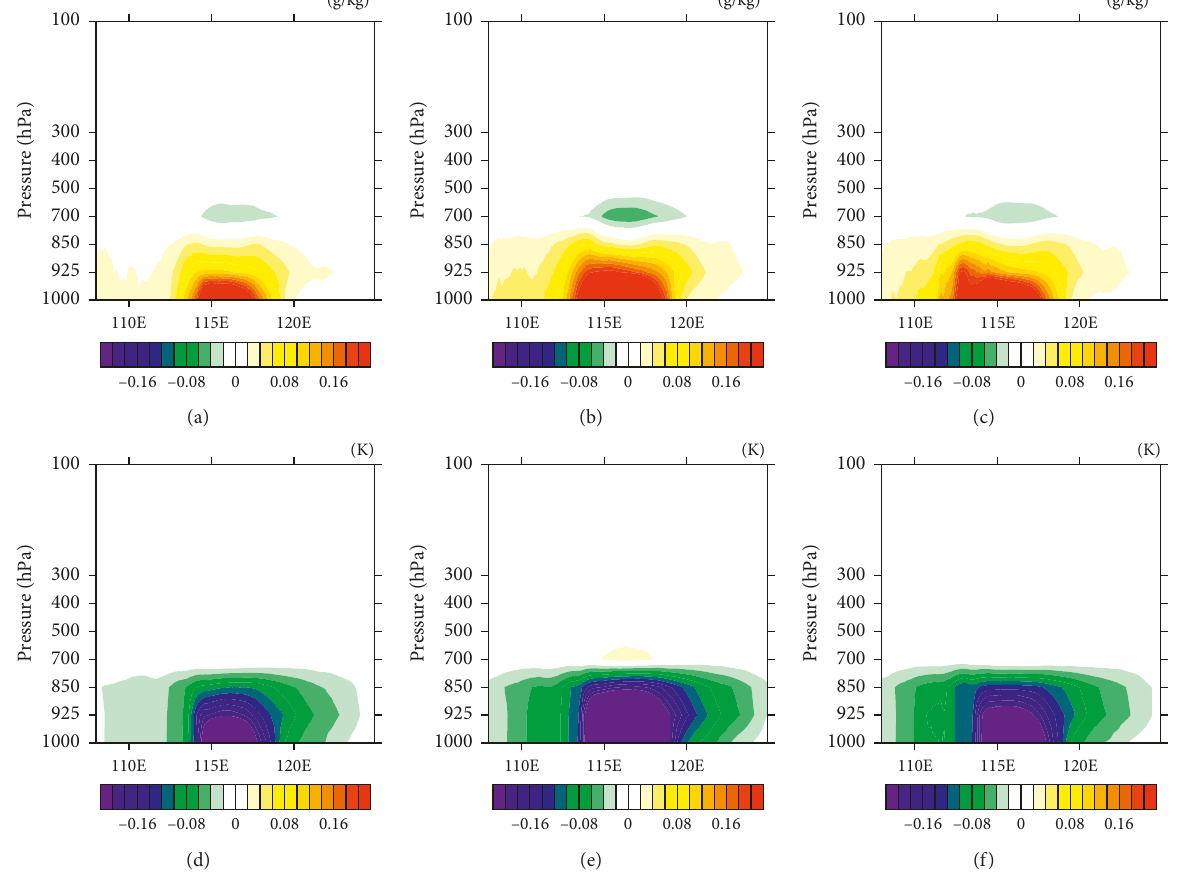
Figure 8: The distributions of longitude vs pressure for mean air humidity difference (a) T1 − CTL, (b) T2 − CTL, (c) T3 − CTL; and air temperature difference (d) T1 − CTL, (e) T2 − CTL, (f) T3 − CTL averaged between 35 ° N and 40 °